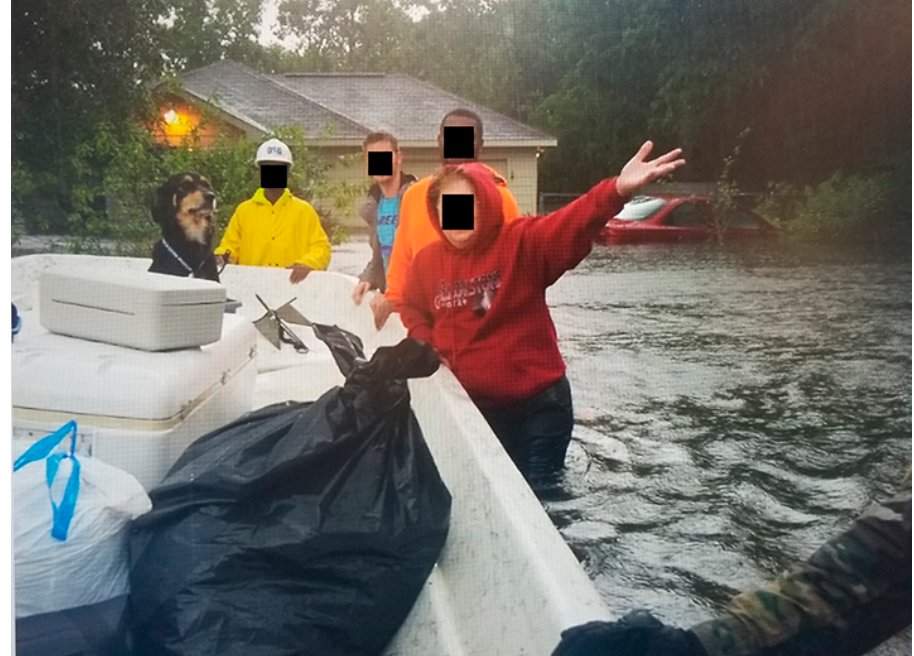
Figure 2. A prototypical scene from the 2017 emergency response to Hurricane Harvey in Dickinson, Texas, where flood survivors are being evacuated from their homes. The Project Lily Pad